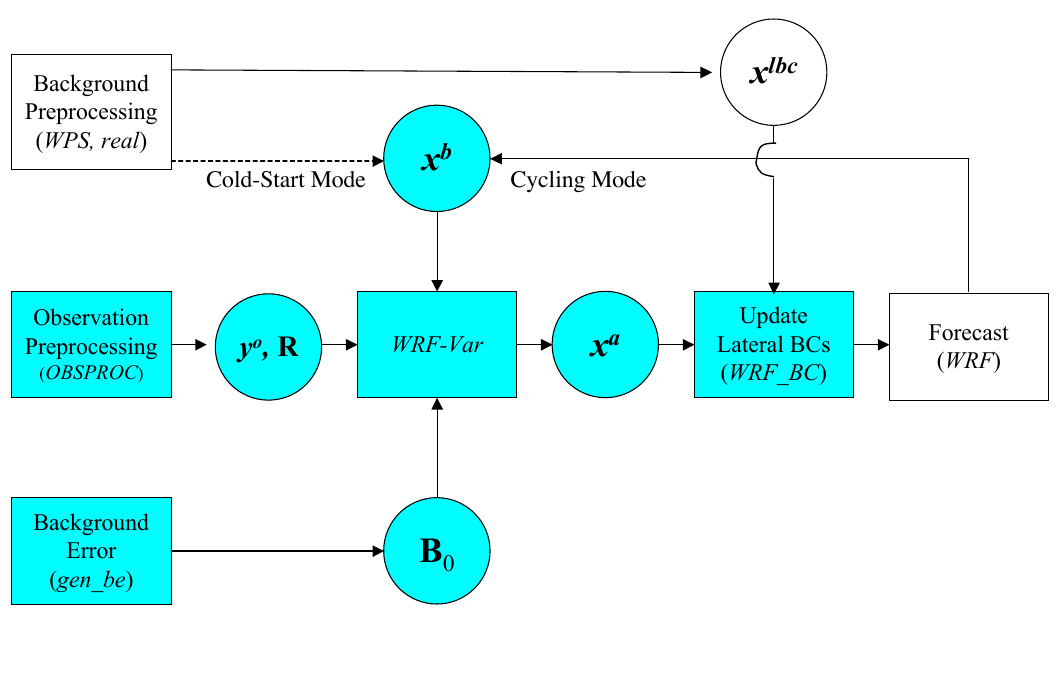
Figure 9.1: Sketch showing the relationship between datasets (circles), and algorithms (rectan- gles) of the ARW